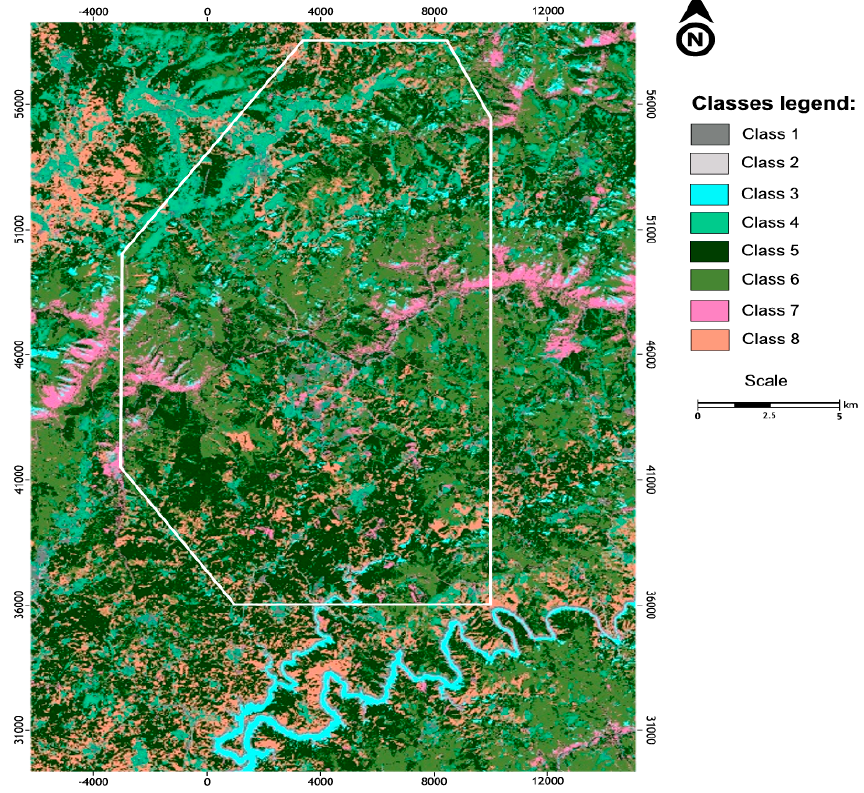
Figure 8. Supervised classification (maximum likelihood) using Landsat 8/OLI bands B2–B8, 8 classes (see text for discussion).